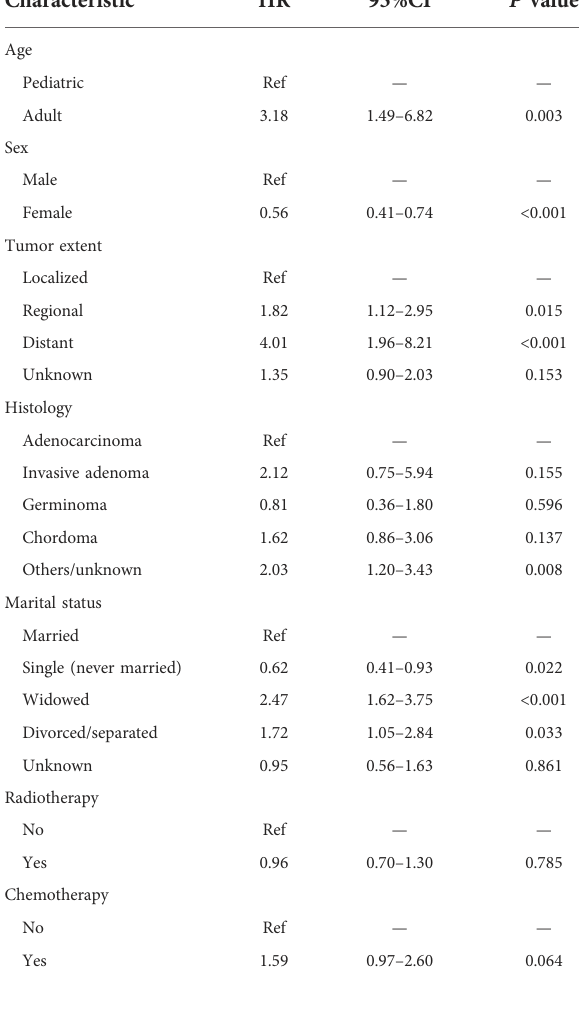
TABLE 2 Multivariate Cox regression analysis for overall survival in patients with primary malignant pituitary